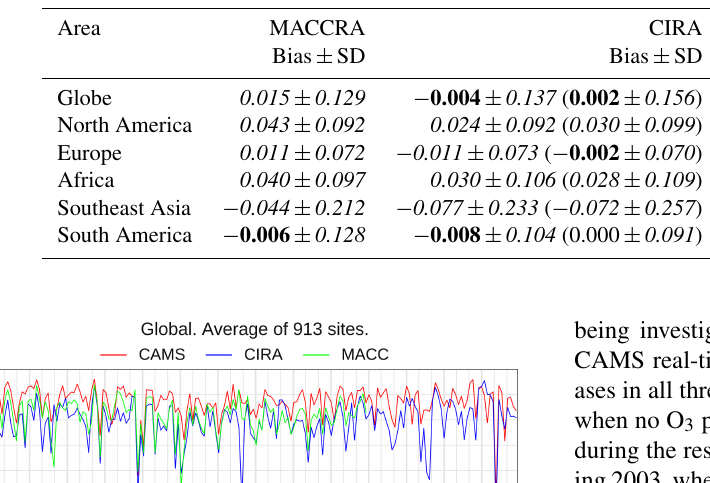
Table 8. Mean biases and standard deviations from MACCRA, CIRA and CAMSRA relative to AERONET data (shown in Fig. 22). The values are calculated for the period 2003–2012, and the values in brackets are calculated for CIRA and CAMSRA for the period 2003–2016. Numbers in italics mark where MACCRA or CIRA have larger biases or a larger standard deviation than CAMSRA, and the numbers in bold mark where their values are smaller. AOD is unitless.